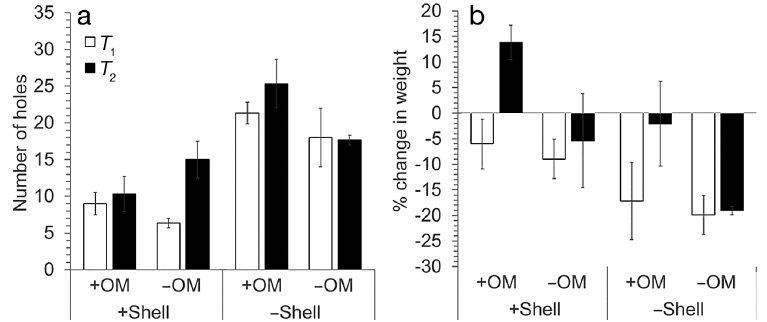
Fig. 3. Effect of presence of shells (+Shell/−Shell) in sediment with different or- ganic matter loads (+OM/−OM) on (a) the number of holes created in the sedi- ment by the polychaetes and (b) the change in weight of the polychaetes at the 2 sampling times: T